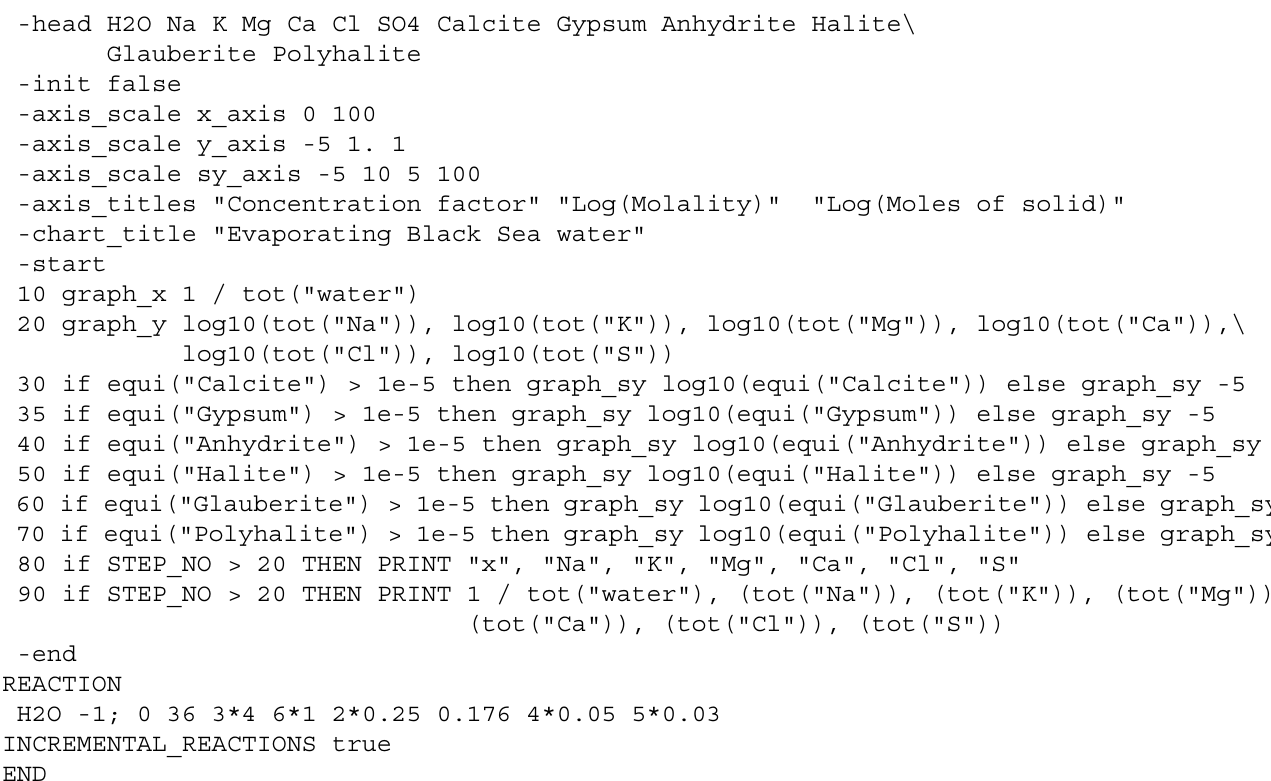
Table 51. Input file for example